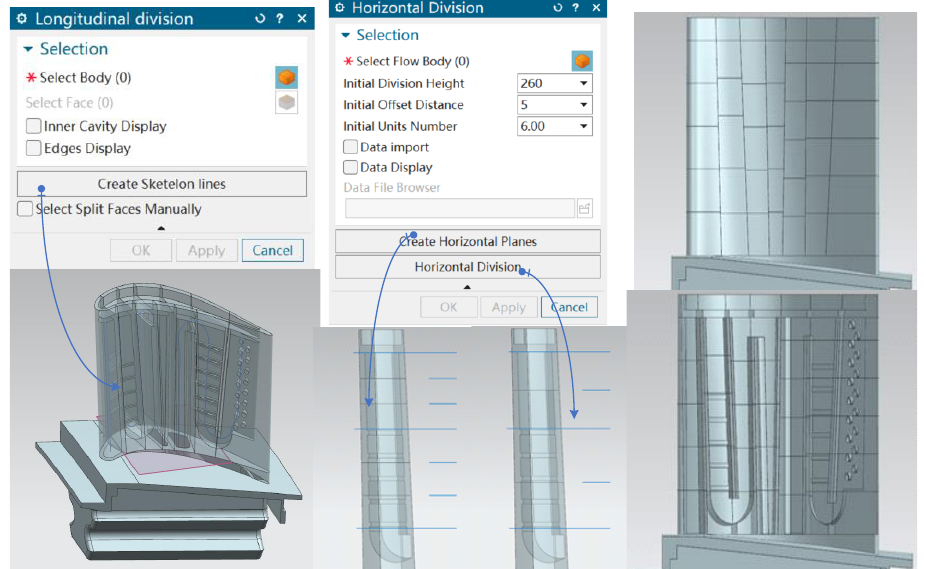
Figure 32. Interface of the adaptive division of flow units based on skeleton lines.